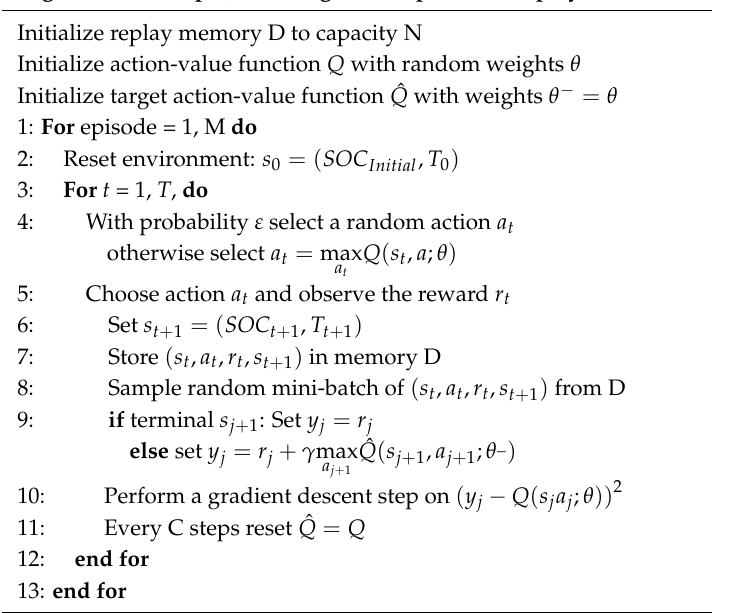
Algorithm 1: Deep Q-Learning with Experience